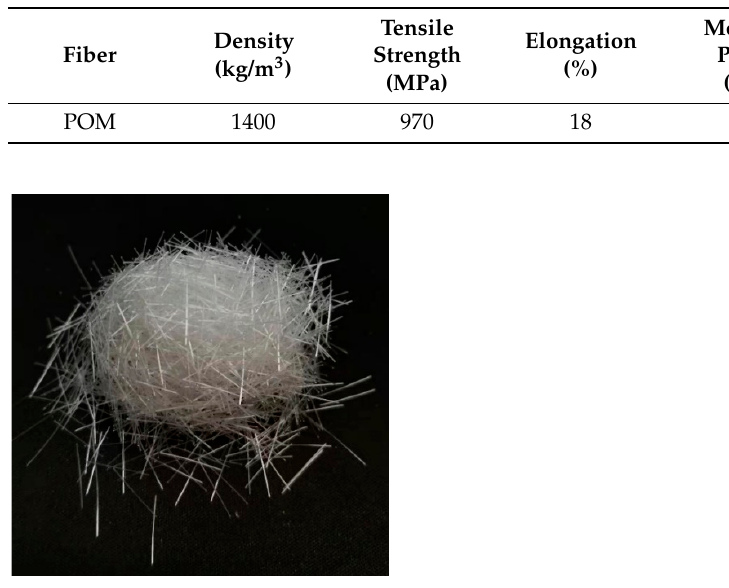
Figure 1. POM fiber used in this study. Table 3. Physical properties of the POM fiber.